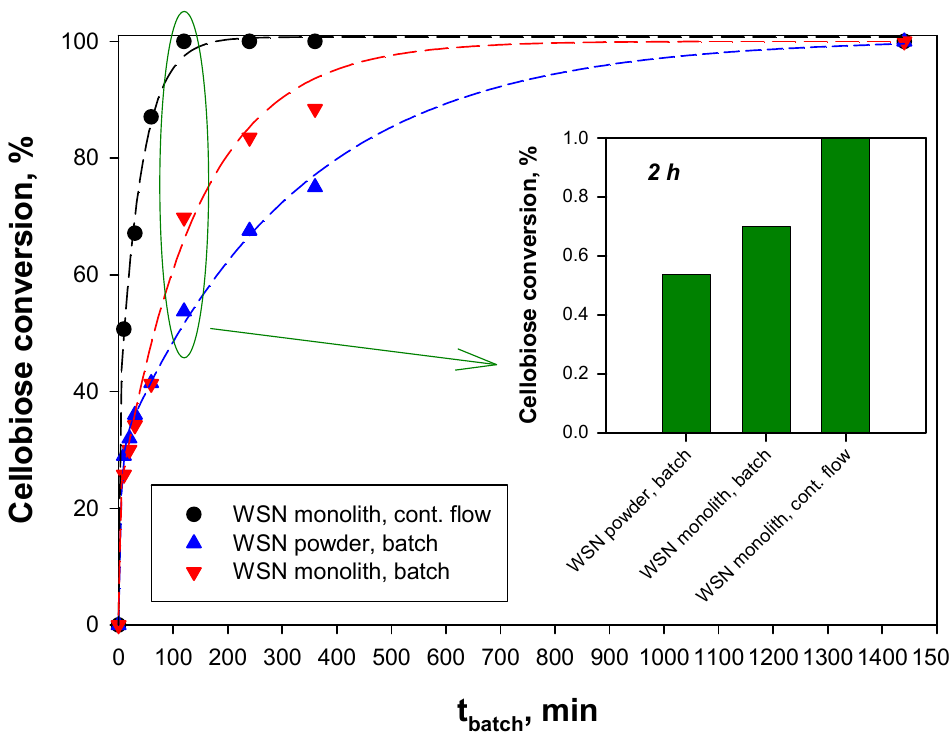
Figure 4. Cellobiose conversion to glucose as a function of the reaction time or the batch-equivalent contact time over WSN catalysts: ( ▲ ) Powder sample, batch reaction; ( ) monolith sample, batch reaction; ( ● ) monolith sample, continuous flow reaction. Temperature: 50 °C.